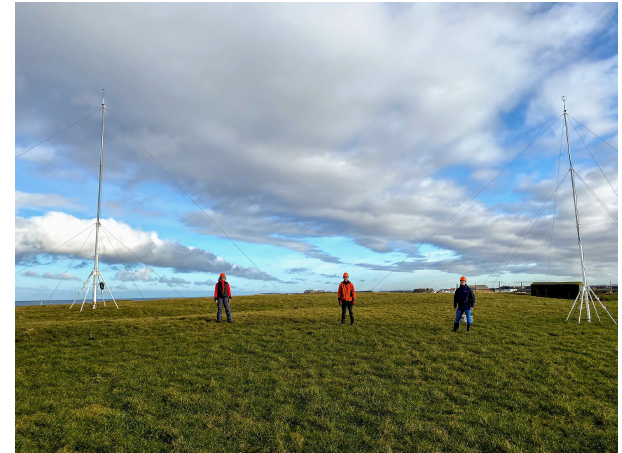
Figure 5. Telescopic masts mounted in a field, approximately 100m north to LidarN, separated by 20m from each other and equipped with one 3D sonic anemometer on their top at a height of 11m above ground